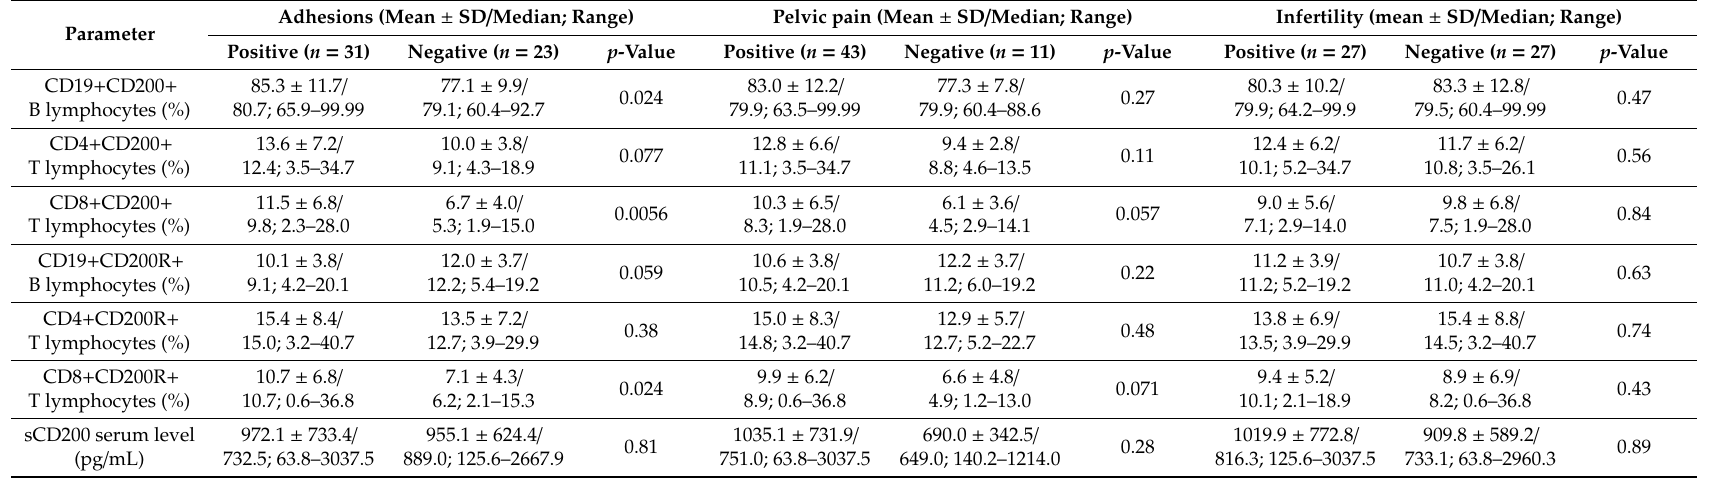
Table 5. The sCD200 serum concentration and frequencies of CD200 and CD200R on T and B lymphocytes in patients with EMS with concomitant adhesions, pelvic pain, or